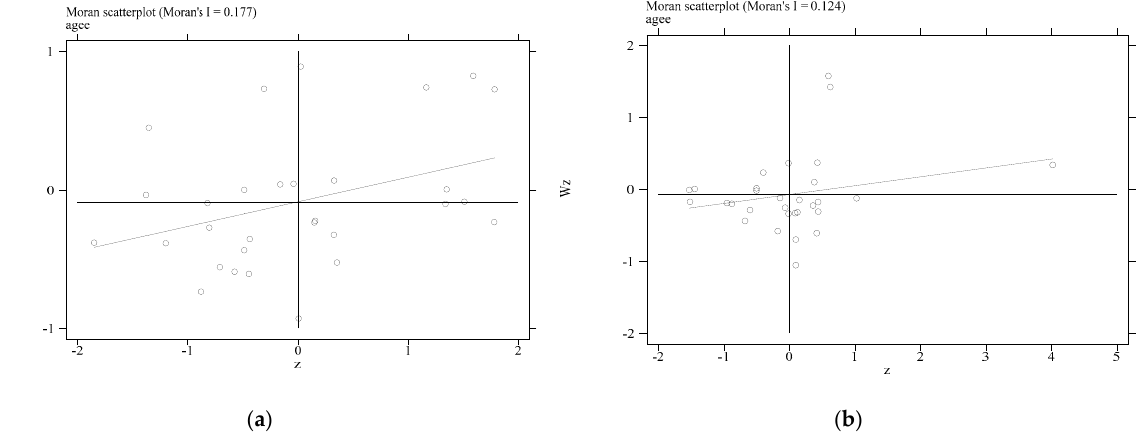
Figure 4. Temporal distribution characteristics of AGTFP. ( a ) Temporal distribution characteristics of AGTFP in eastern region; ( b ) temporal distribution characteristics of AGTFP in central region; ( c ) temporal distribution characteristics of AGTFP in western region; ( d ) temporal distribution characteristics of AGTFP in all regions.